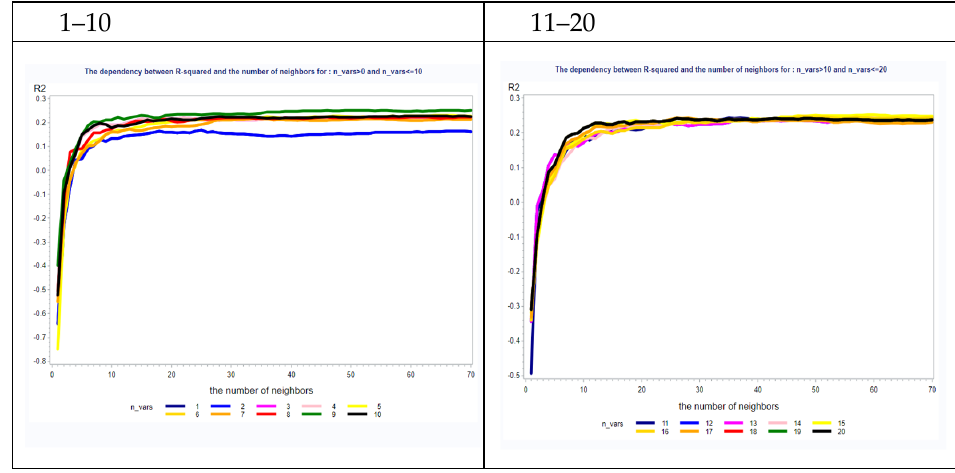
Figure 2. Results of discriminatory power of the model split by the number of variables used in the metric in the batches.